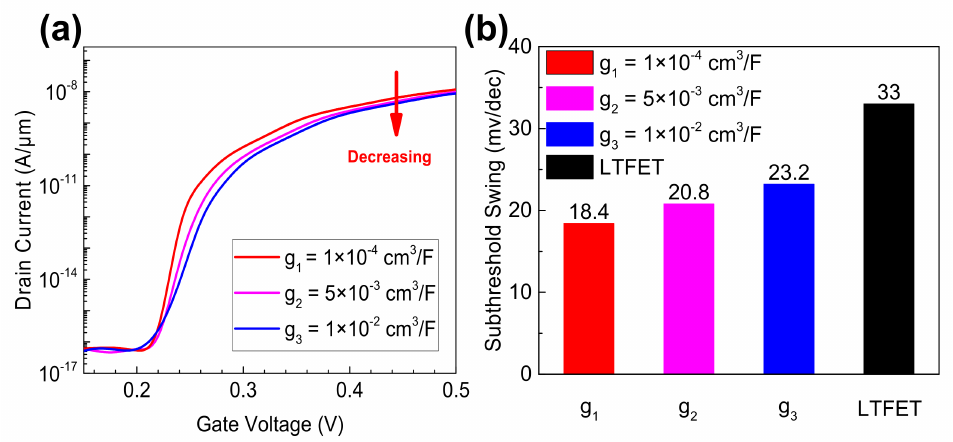
Figure 6. ( a ) The transfer characteristic curves under different g values and ( b ) the influence of g on